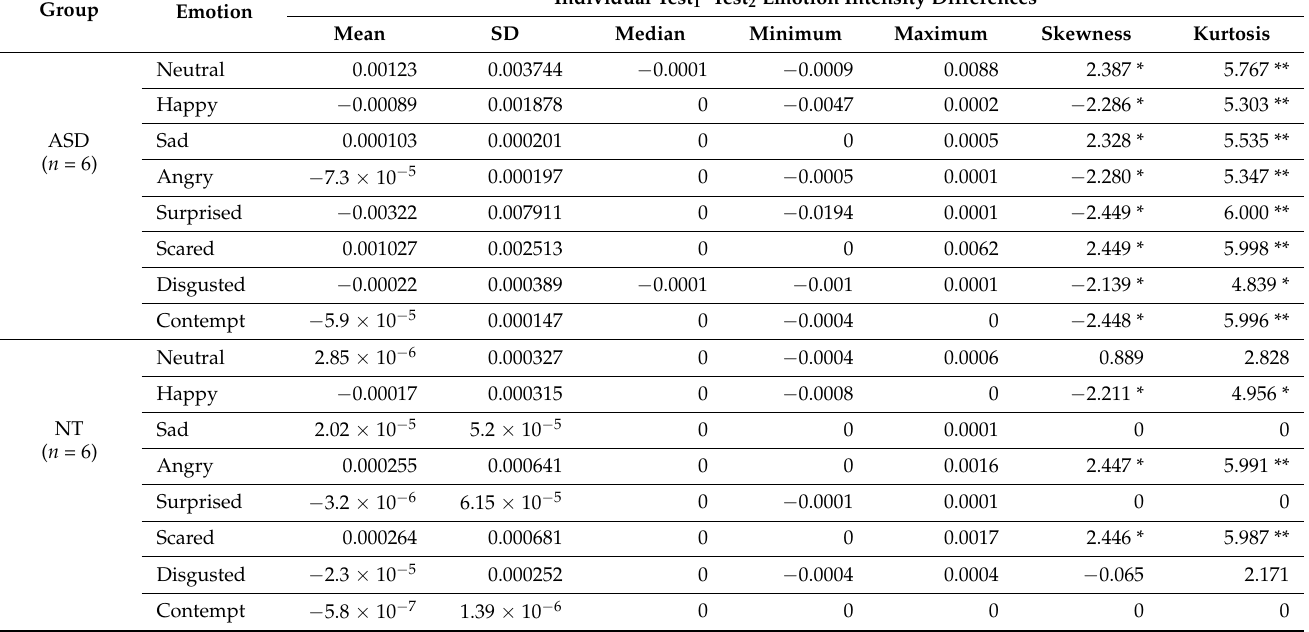
Table A2. Descriptive statistics of test 1 –test 2 emotion intensity differences averaged over total play time (all data points), separately for each emotion. Group means were calculated from individual means. Cases with identical test 1 –test 2 data series are not included. Case numbers are too low for normality test. Notation: *: p < 0.05; **: p < 0.01.